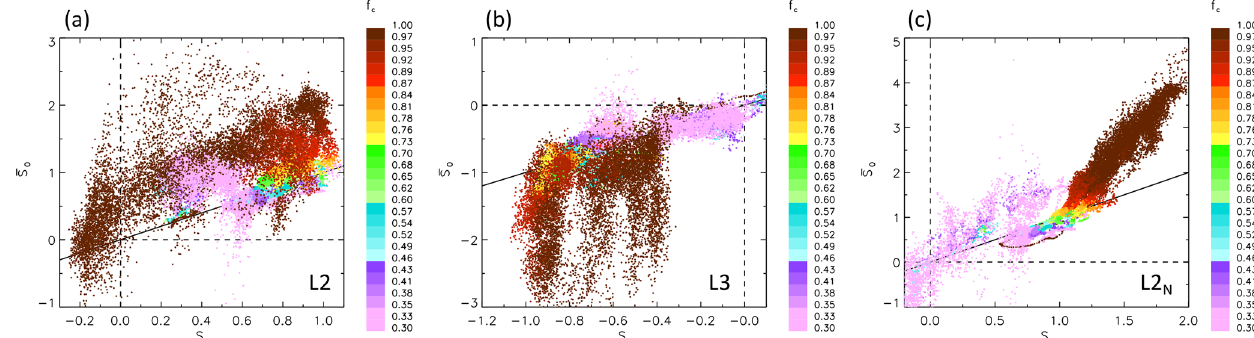
Figure 3. S o aggregated to a 6km scale ( S o ) vs. S o aggregated to an 800m scale ( S o ) for the (a) L2, (b) L3, and (c) L2 N methodologies as described in the text. Solid line is the 1 : 1 line. Dashed lines are drawn at ordinate and abscissa values of zero. Note the general overestimate in S o with increasing aggregation scale in (a) and (c) and the change in sign in S o associated with L3 aggregation in (b) . Of note is that high-cloud-fraction/low-heterogeneity conditions are often associated with high biases.